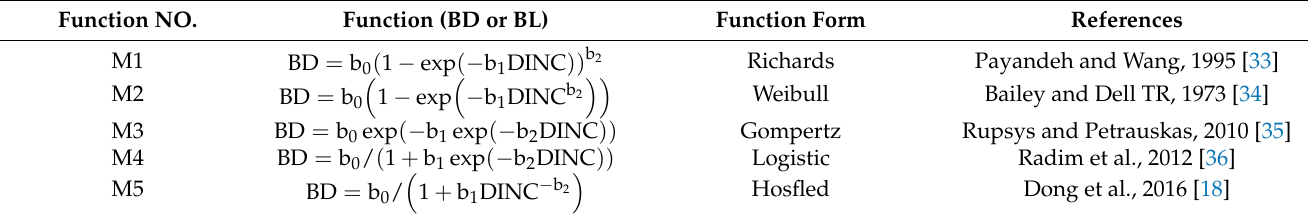
Table 3. A list of equations used for modeling branch diameter and branch length of the Korean pine